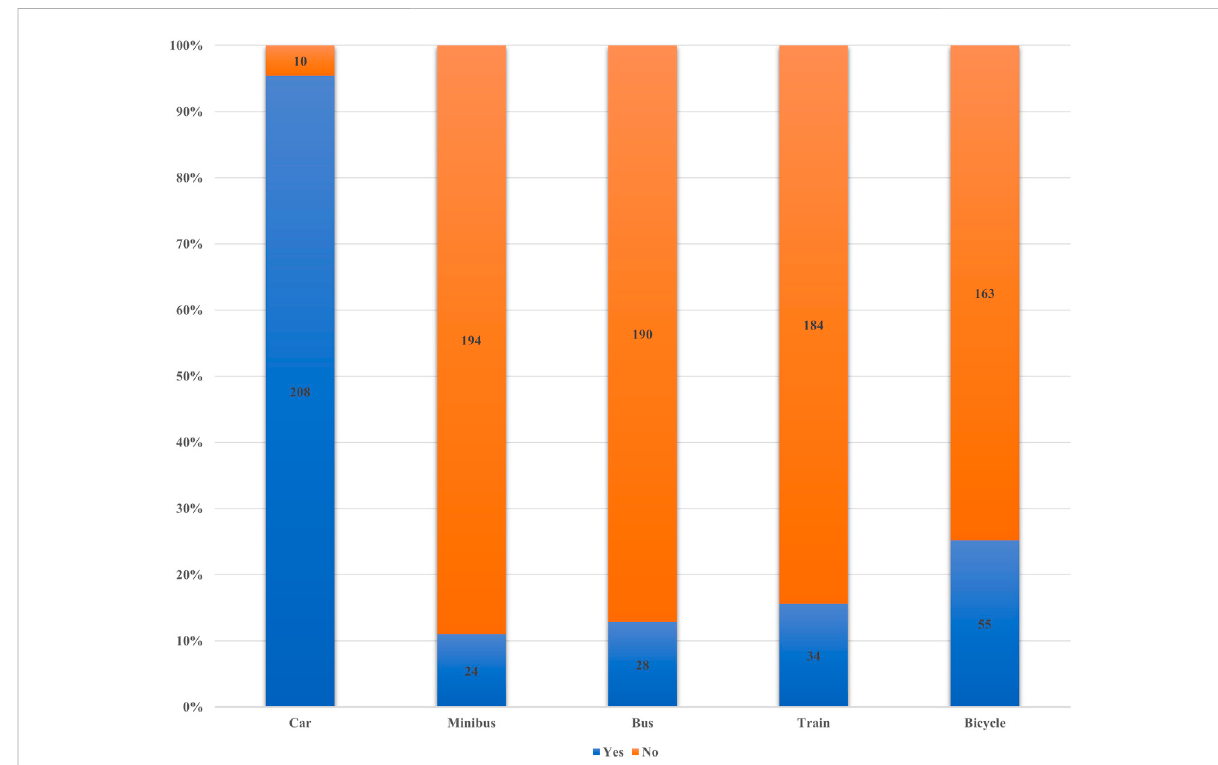
FIGURE 9 Means of transport used by young people during holidays spent in ecotourism destinations.